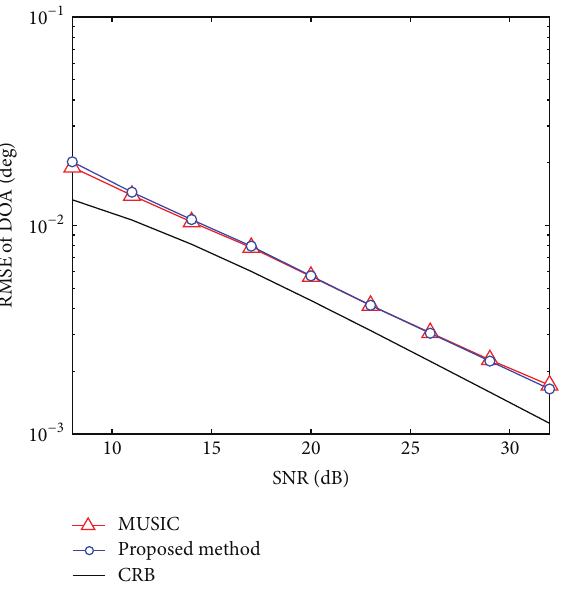
Figure 5: Resolution probability against the angular separation, where the strong source is located at (𝜃 1 , 𝛾 1 ) = (3 ∘ ,30 ∘ ) and the weak source is located at (𝜃 2 ,𝛾 2 ) = (𝜃 1 + Δ,35 ∘ ) with SNR = 5 dB.